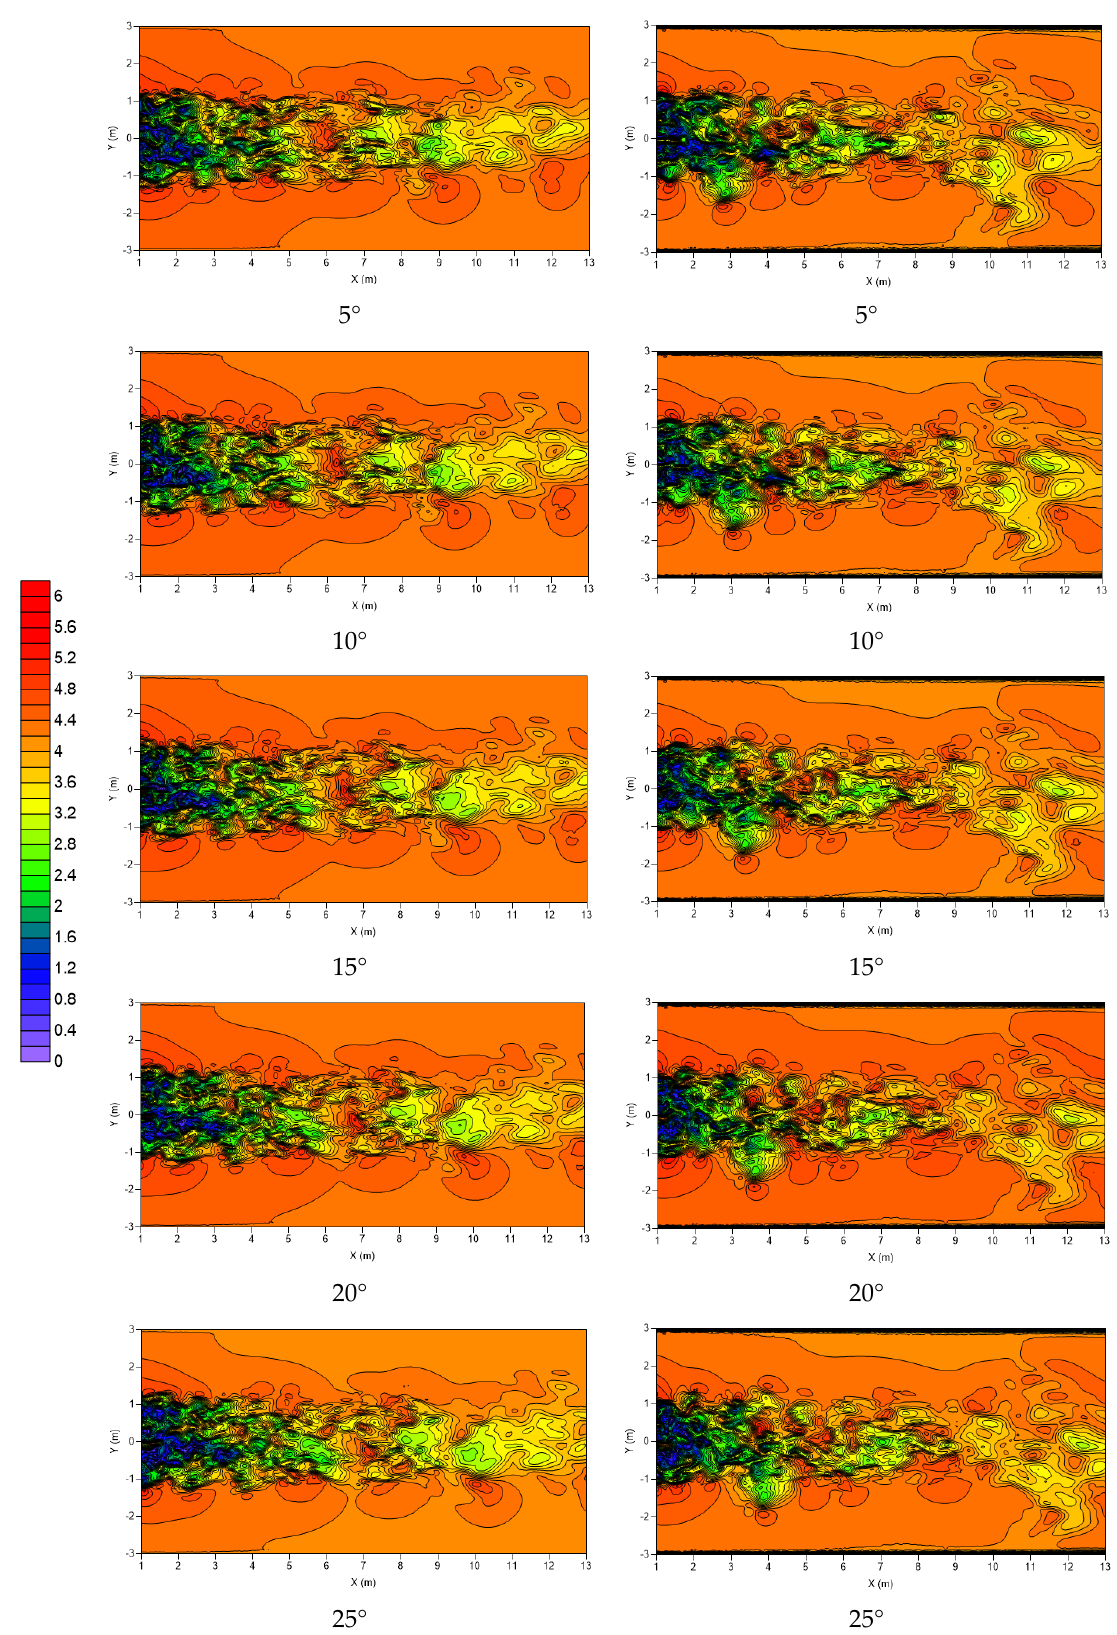
Figure 9. Spatial distribution of flow velocity magnitude (in m/s) in the wake region of healthy and damaged VAWTs.